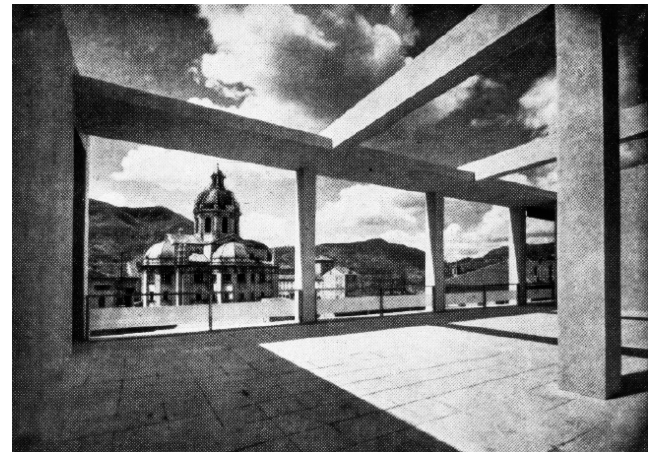
Figure 18 . Casa del fascio by Giuseppe Terragni. Como (1932–1936). The terrace. Photo from (Sartoris 1941, p. 399).